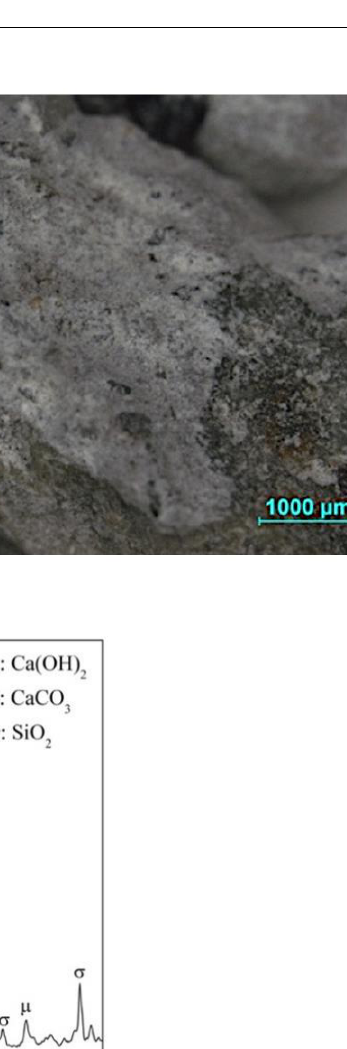
Figure 3. Mineralogical composition of RFA.